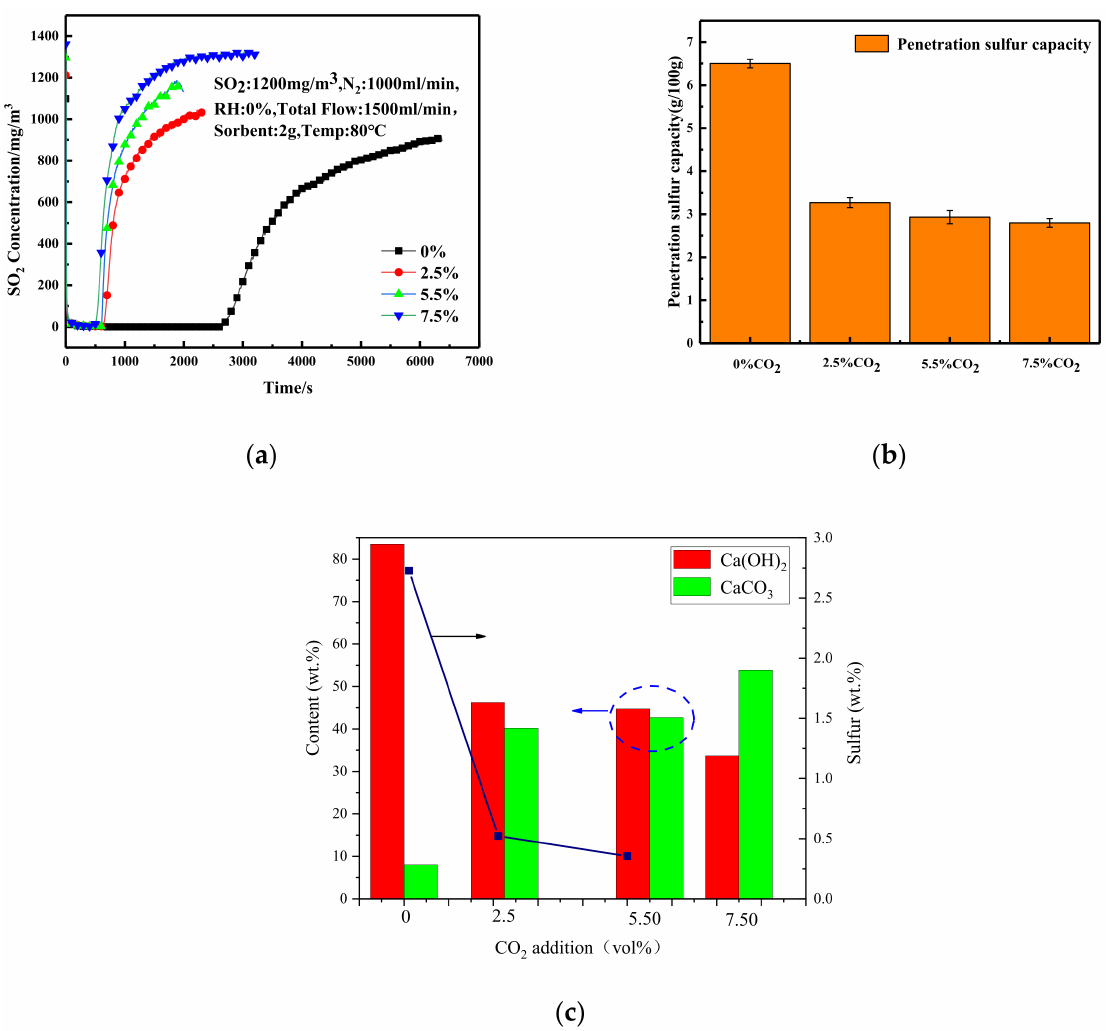
Figure 7. Effect of CO 2 concentrations on ( a ) desulfurization performance; ( b ) sulfur penetration capacity; ( c ) relative content of Ca(OH) 2 and CaCO 3 in desulfurization as4. Effect of relative